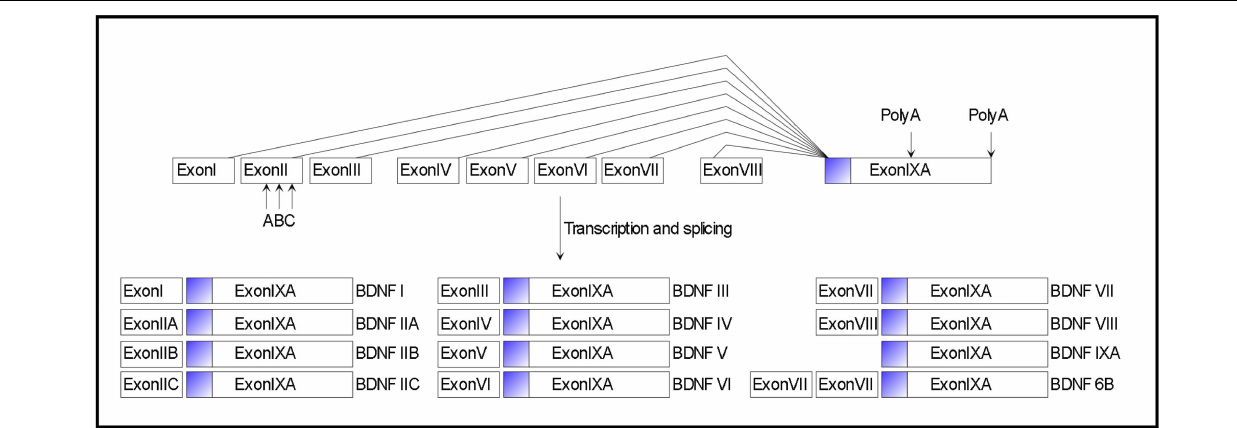
FIGURE 1 | Mouse and rat Bdnf gene structure and transcripts. Exons are indicated by boxes. Filled box in exon IXA indicates the coding region of the Bdnf gene. Lines indicate splice variants. Arrows indicate within-exon splice sites and alternative polyadenylation sites. The Bdnf gene is transcribed from different